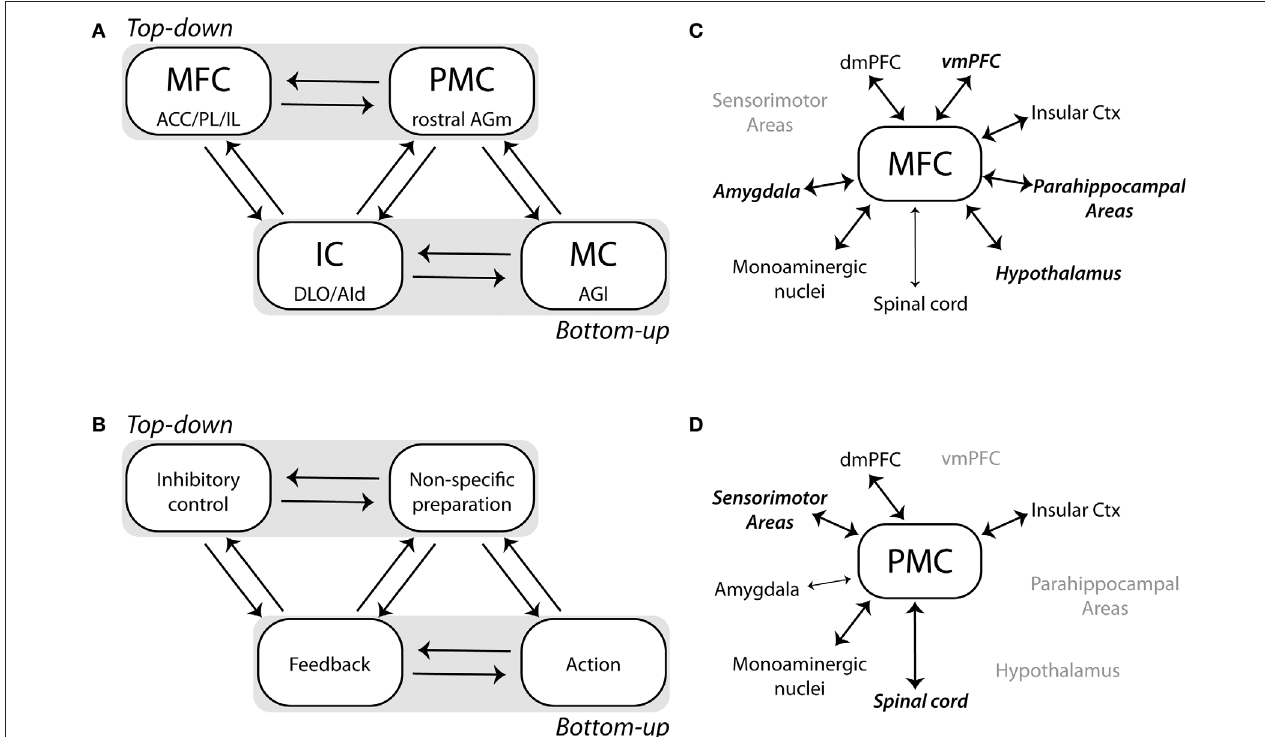
(MC), located in the lateral agranular area (AGl), interacts with PMC and IC allowing for bottom–up control, with proprioceptive feedback from the motor cortex and taste-based feedback from IC. (C,D) A survey of the anatomical literature (see text) reveals several key brain regions that are selectively connected with either the MFC or PMC networks. Dorsal areas in MFC are extensively interconnected with the ventral infralimbic area, the amygdala, parahippocampal regions, and the hypothalamus. By contrast, PMC lacks connectivity with these regions and is heavily interconnected with sensory and motor brain regions, including the spinal